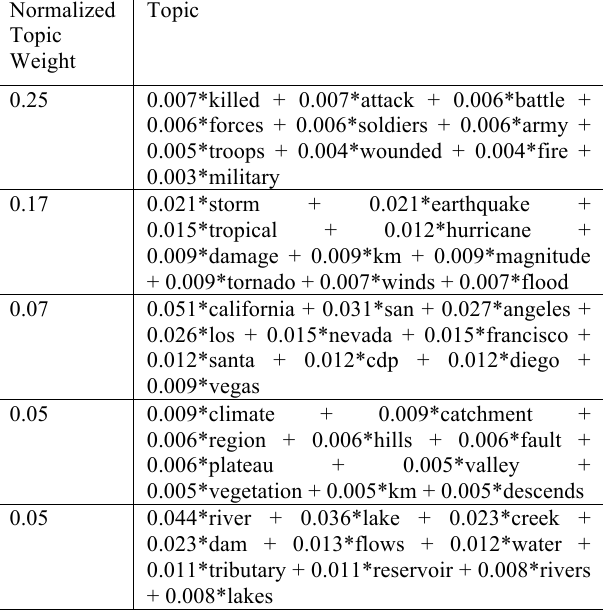
Table 2. Top five topics and their highest value words related to wildfires in